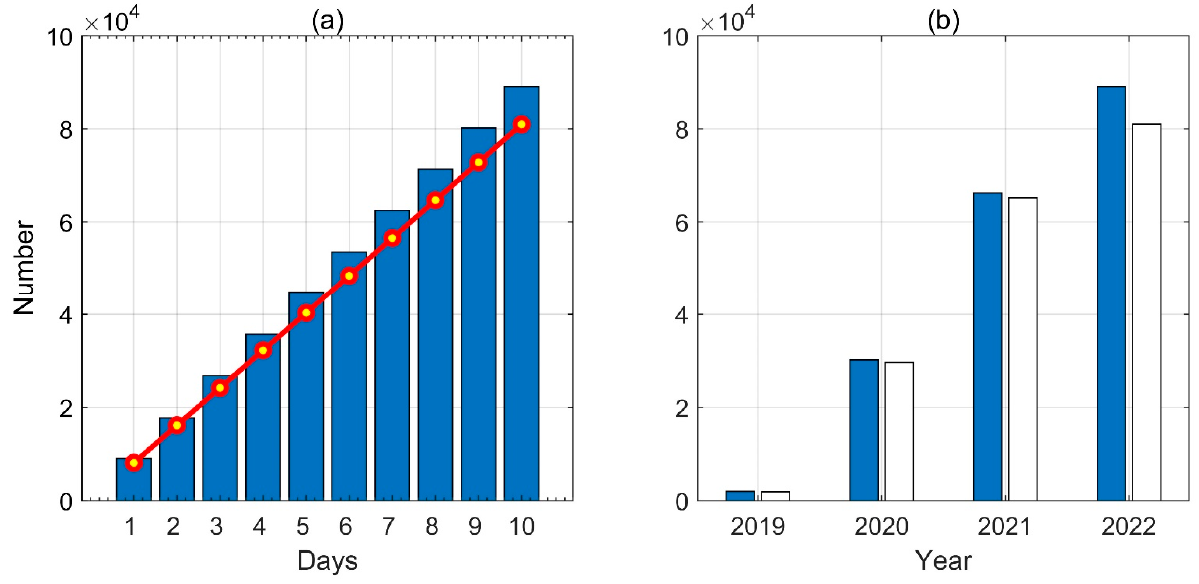
Figure 6. ( a ) Number of satellites that pass through the SYISR with different accumulated days based on the latest StarLink constellation orbits. The red line is the number of satellites that appear at altitudes above 500 km. ( b ) The yearly variations of satellite numbers that pass through the detection region of SYISR over 10 days (the blue bar is the total number, and the white bar is the number at altitudes above 500 km). The orbit information is based on the latest StarLink constellation satellites.